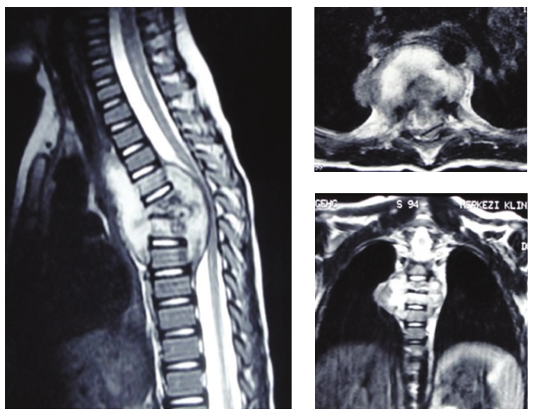
Figure 1: Preoperative MR images demonstrated a large paraspinal abscess.